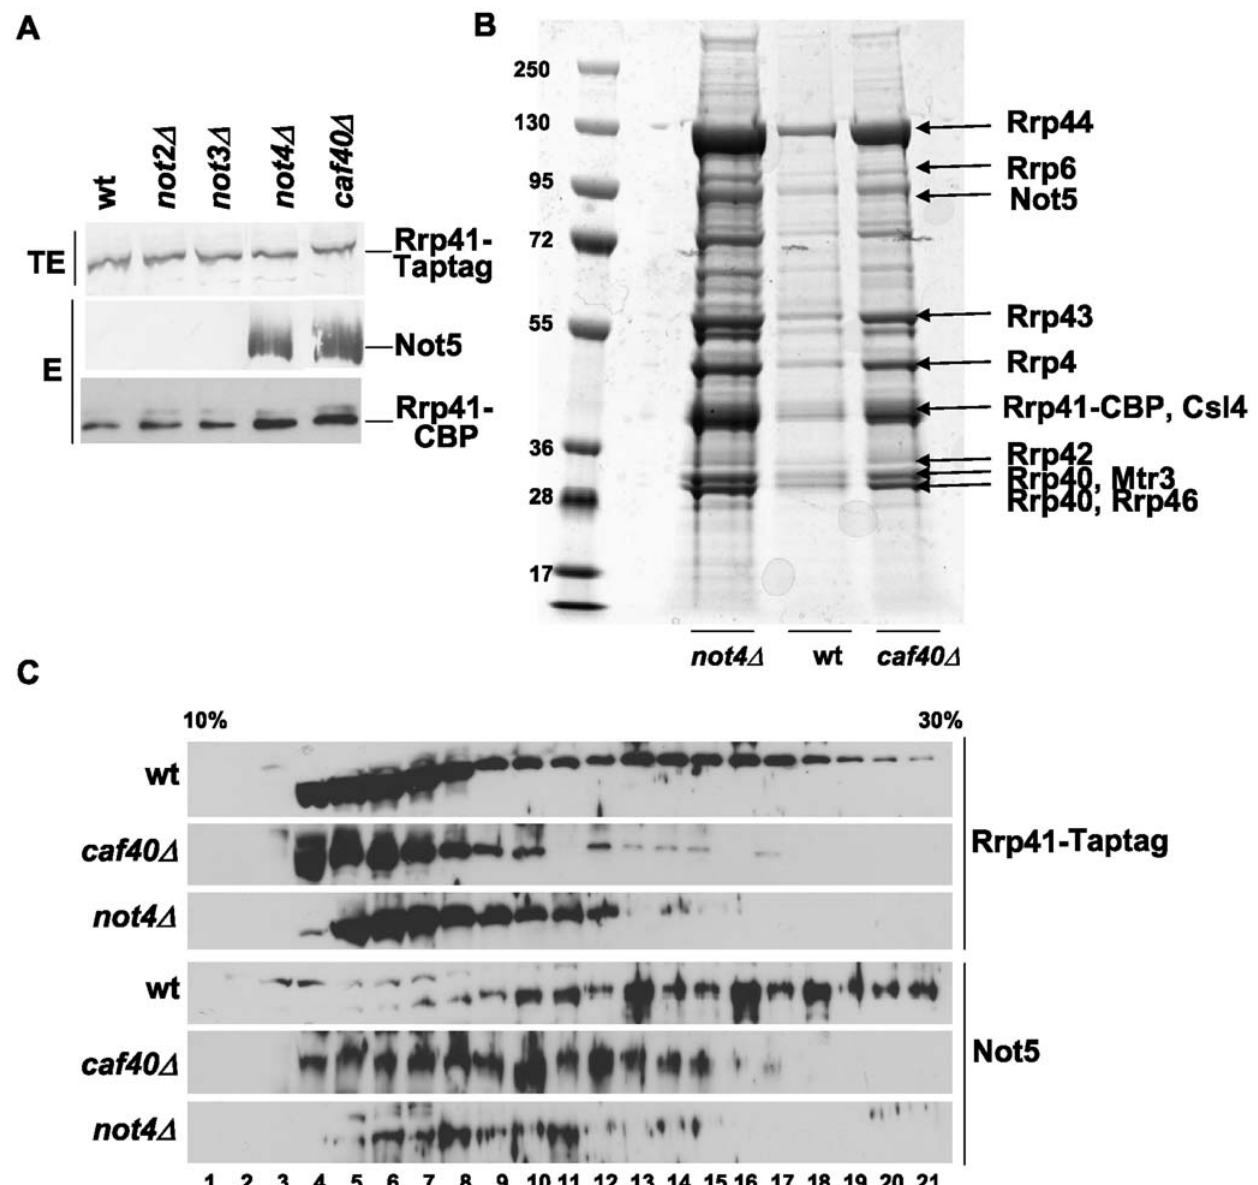
Figure 4. Large complexes containing Rrp41 and Not5 are disrupted in cells lacking Caf40 or Not4. A . Equal amounts of total protein extracts (TE) from the indicated strains expressing Tap-tagged Rrp41 were analyzed by western blot for the expression of Rrp41 with antibodies against CBP. Purified materials (E) were analyzed for the presence of Not5 and Rrp41 by western blotting with antibodies against Not5 and CBP as indicated. B and C . Wild-type, caf40 D or not4 D cells expressing Tap-tagged Rrp41 were grown for extract preparation. B. 2 g of extract were used to purify Rrp41 and the eluted proteins were loaded on SDS-PAGE. The gel was stained with coomassie. The nuclear exosome subunits and Not5 identified by mass spectrometry (Table S3) are indicated. Molecular weight markers are indicated on the left (in kDa). C. 5 mg of extracts were loaded on a 10–30% glycerol gradient. Proteins in the different fractions of the gradient were analyzed by western blotting for the presence of Tap-tagged Rrp41 with antibodies against CBP, and for Not5 with antibodies against Not5, as